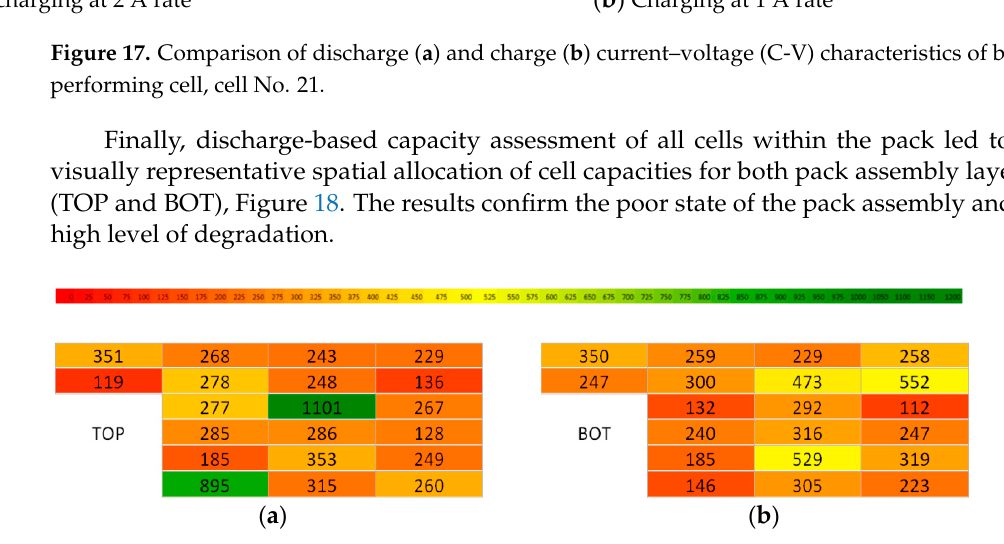
Figure 18. Spatial distribution of TOP/upper- ( a ) and BOT/lower-layer ( b ) pack cells capacities. In order to confirm cells’ capacities determined with the discharging method, a second approach was employed to validate the results. That approach relied on and utilized the charge counting method while the cell was charged up to its maximum voltage but with current that was lower in relation to the nominal discharge current of 2 A—i.e., charge current of 1 A was used. The results of the capacities determined in this way are shown in Table 3. Table 3. Battery pack cells parameter values during 1 A charge. Cell